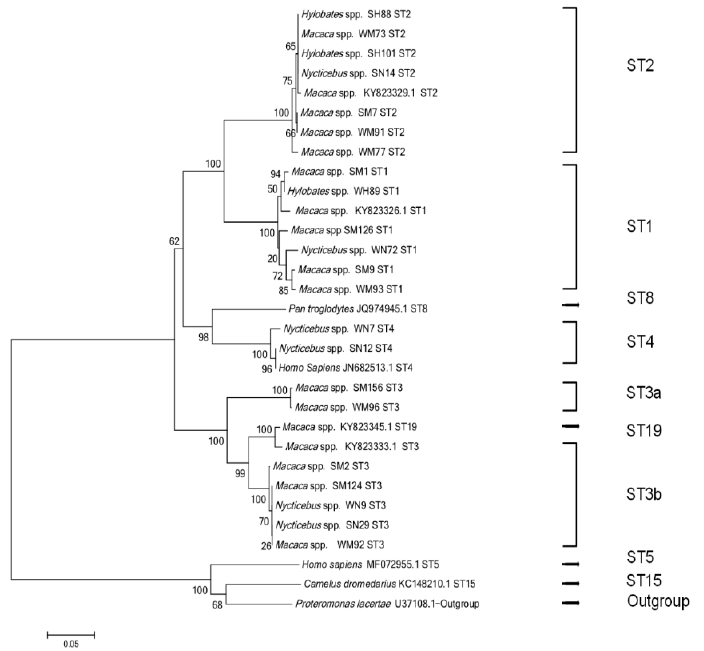
Figure 1. Phylogenetic relationship of Blastocystis sp. based on the nucleotide sequences of the barcode regions of small subunit ribosomal RNA (SSU rRNA). The neighbor-joining method was used to construct the trees using the Kimura-2-parameter model. The numbers on the branches are the percent bootstrap values from 1000 replicates. Each sequence was identified by its host, accession/association number, and